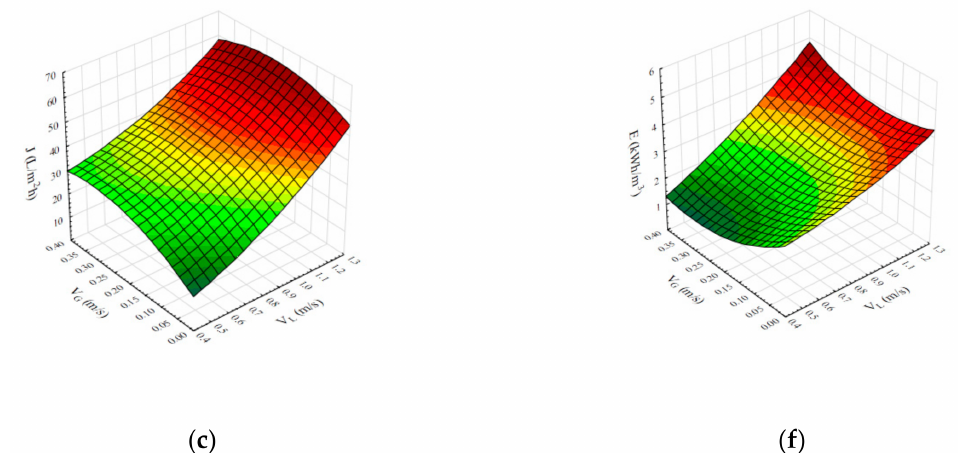
Figure 1. Response surface plots representing the regression models for steady state permeate flux ( a – c ) and specific energy consumption ( b – d ) during microfiltration of Bacillus velezensis IP22 cultivation broth aided with air sparging. The response surface plots represent the following effects of the independent variables to the aforementioned responses: ( a ) transmembrane pressure (TMP) and superficial feed velocity (V L ) to permeate flux (J); ( b ) transmembrane pressure (TMP) and superficial air velocity (V G ) to permeate flux (J); ( c ) superficial feed velocity (V L ) and superficial air velocity (V G ) to permeate flux (J); ( d ) transmembrane pressure (TMP) and superficial feed velocity (V L ) to specific energy consumption (E); ( e ) transmembrane pressure (TMP) and superficial air velocity (V G ) to specific energy consumption (E); ( f ) superficial feed velocity (V L ) and superficial air velocity (V G ) to specific energy consumption